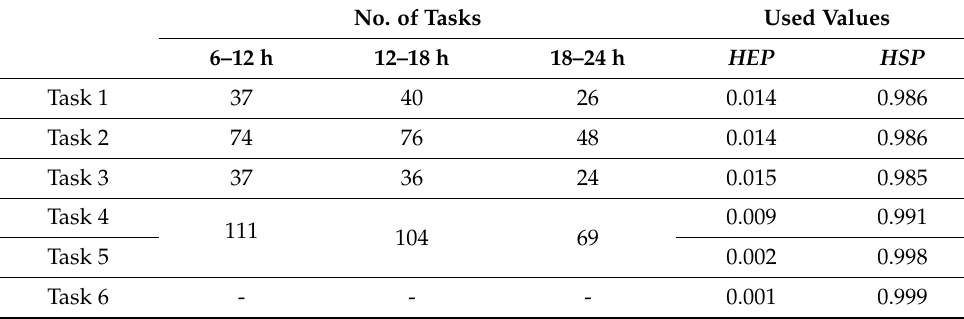
Table 13. Final overview of workplace A.